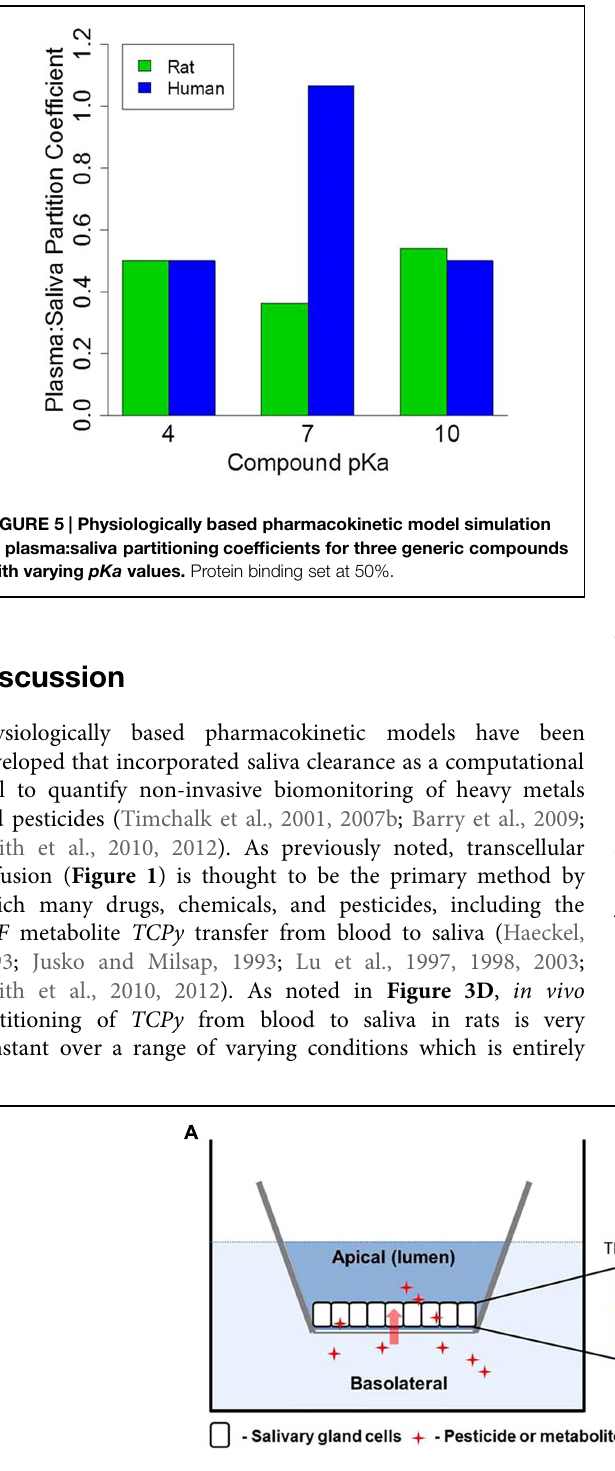
electrical resistance (TEER). (C) Western blot analysis showing expression of α -amylase and AQ5 proteins in SGEC lysates indicative of acinar cells; and (D) four-compartment (blood: RBC/plasma and salivary gland: interstitial and cellular space) model structure for calculating steady-state transport.